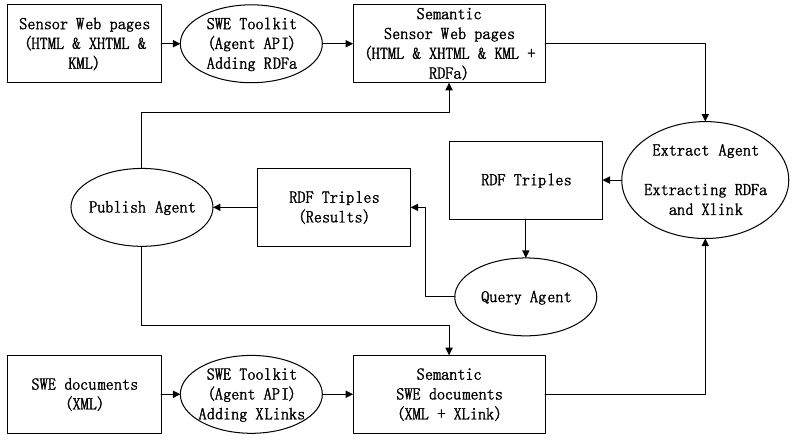
Figure 6. Semantic Enablement Agents.